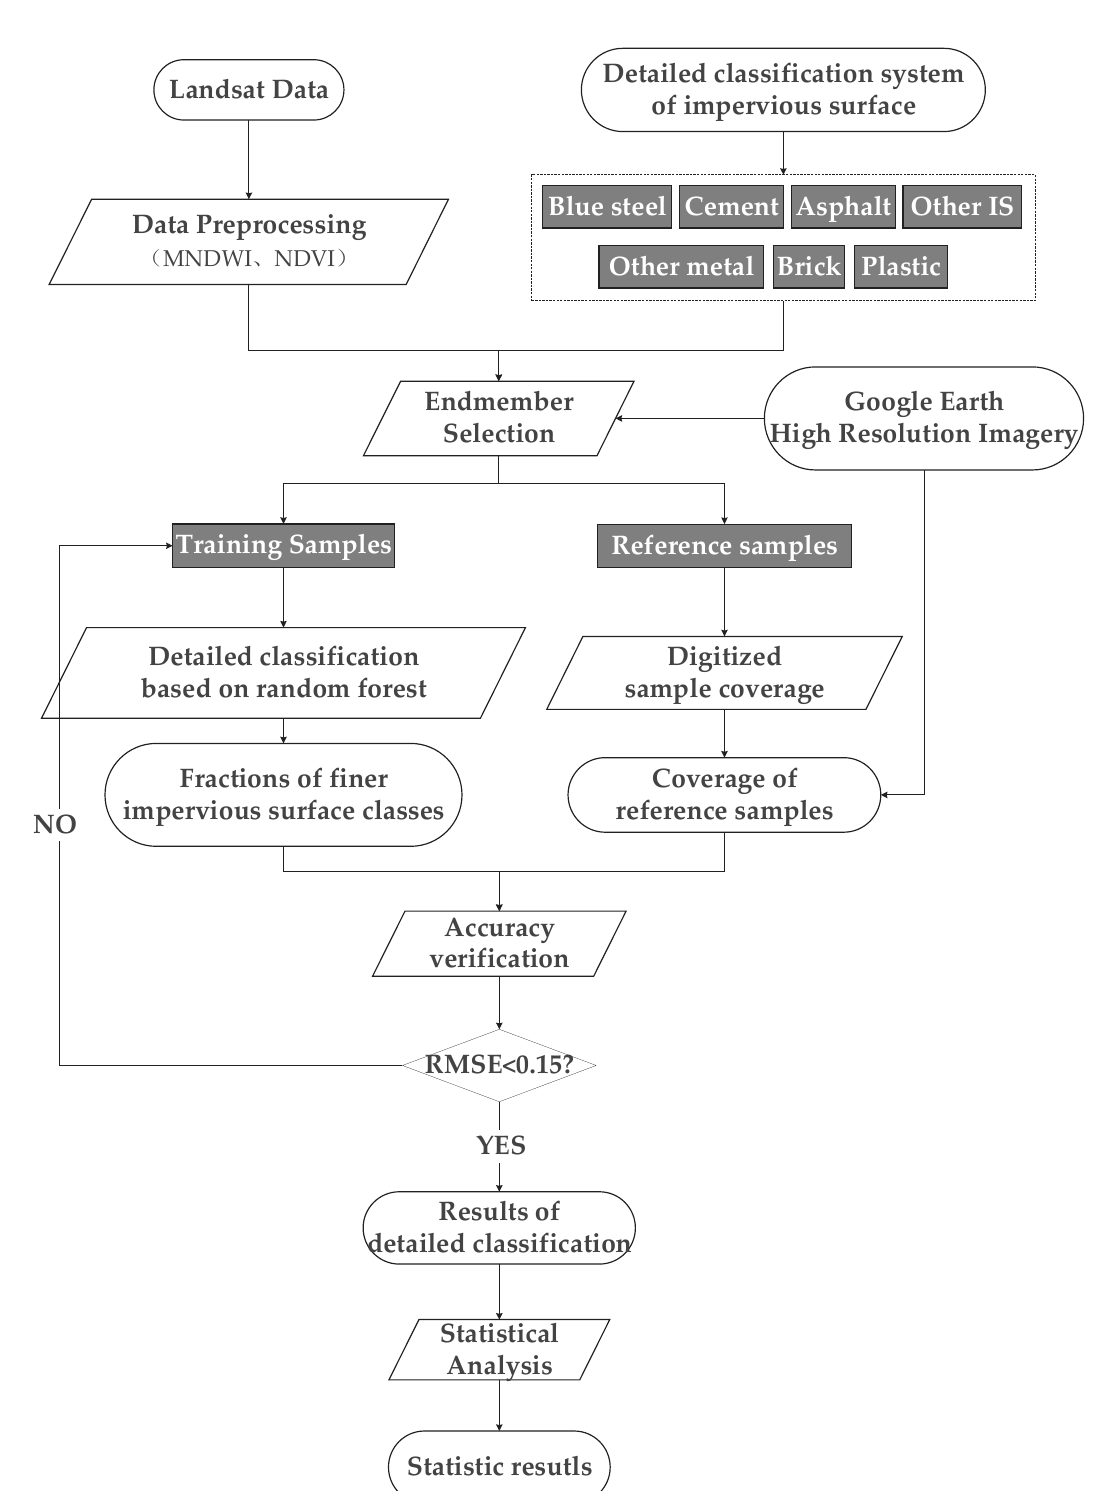
Figure 4. Flow chart of classification procedure (MNDWI: modified normalized difference water index; NDVI: normalized difference vegetation index; Other IS: other impervious surface; RMSE: root mean square error).